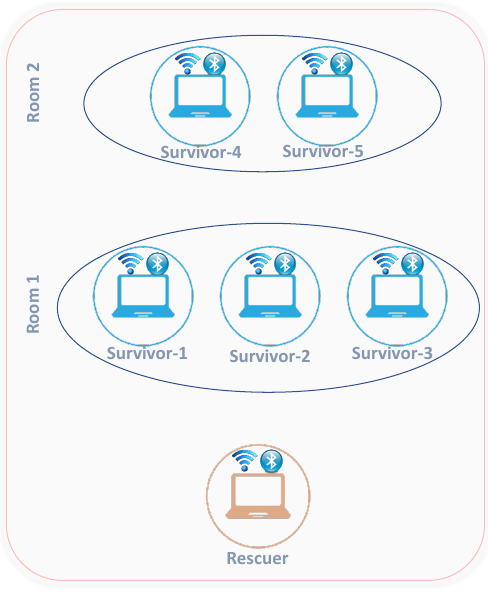
Figure 5. Proof-of-concept